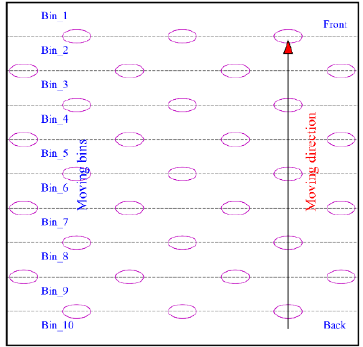
Figure 23. Bin groups for the angular velocity.